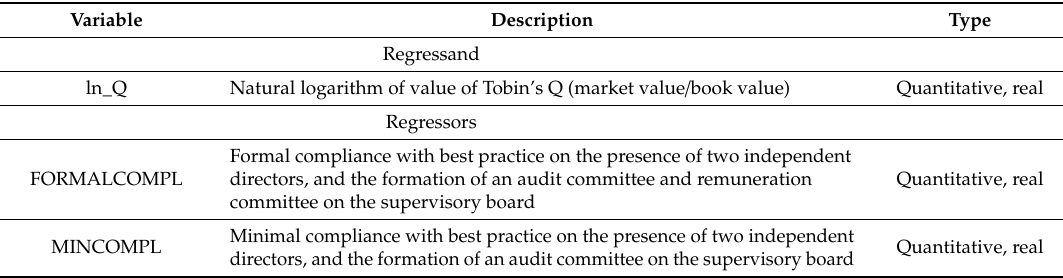
Table 2. Summary of